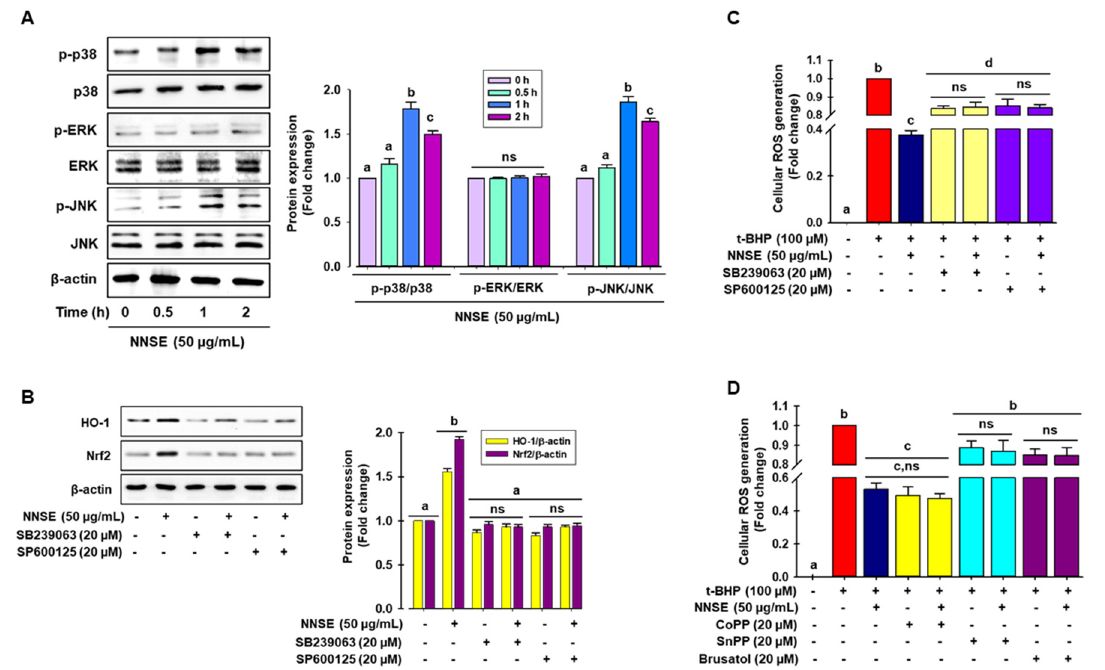
Figure 7. Activation of p38 and JNK by NNSE results in Nrf2 translocation. ( A ) RAW 264.7 cells were treated with NNSE (50 µg/mL) for various times, and kinase activity was determined by immunoblot assay. ( B ) Cells were treated with NNSE and specific inhibitors, SB239063 (p38 inhibitor) and SP600125 (JNK inhibitor), for 1 h, and Nrf2 and HO-1 protein levels were analyzed by western blot analysis. ( C ) Cells were treated with NNSE and the specific inhibitors, SB239063 and SP600125, and cellular ROS generation was quantified by the DCFH-DA methods. ( D ) Cells were treated with NNSE and CoPP (HO-1 activator), SnPP (HO-1 inhibitor), and brusatol (Nrf2 inhibitor), and cellular ROS generation was quantified by the DCFH-DA methods. Values are expressed as the mean ± SD ( n = 3), and different letters are considered statistically significant ( p < 0.05) to one another.